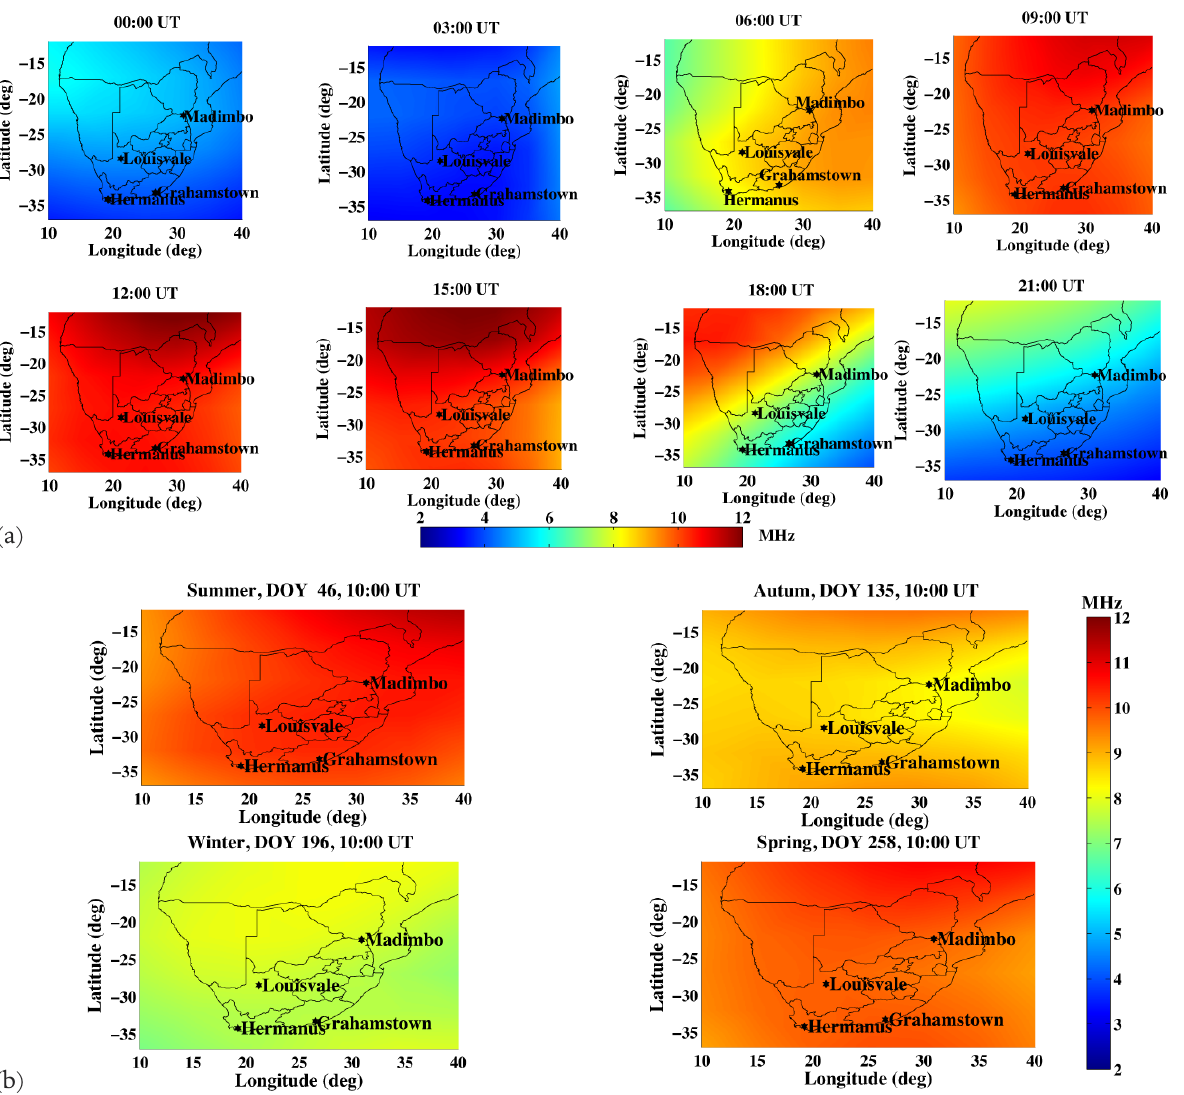
Figure 8. foF2 maps generated by SAIM. (a) Diurnal variation, (b) seasonal variations: summer, autumn, winter and spring in